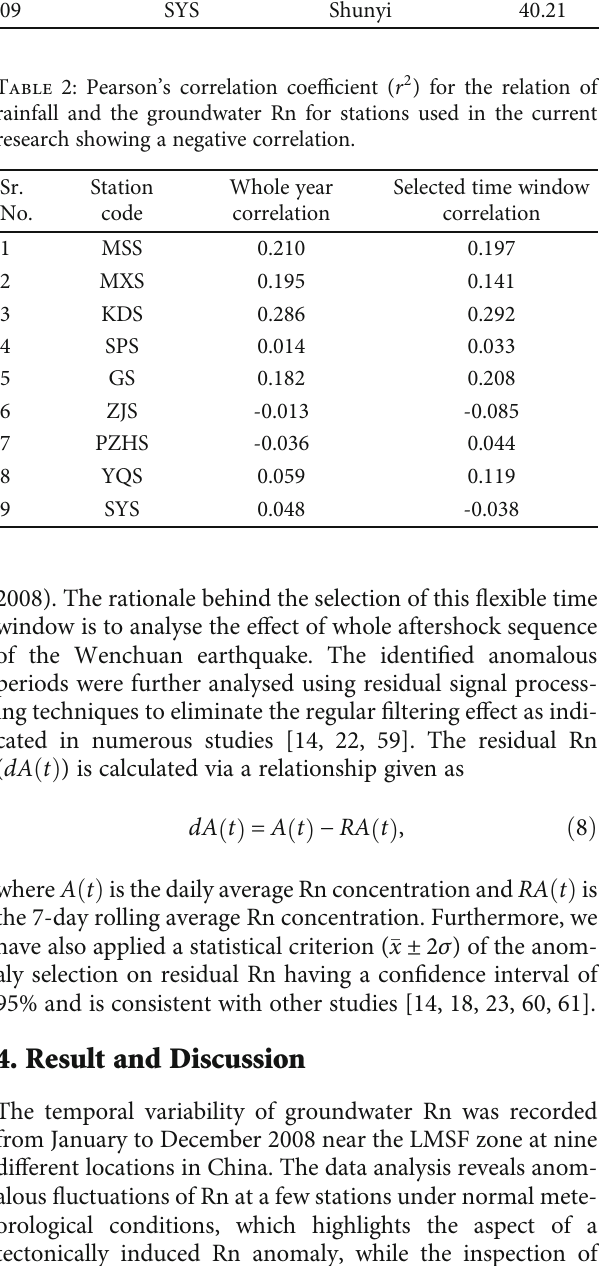
Table 2: Pearson ’ s correlation coe ffi cient ( r 2 ) for the relation of rainfall and the groundwater Rn for stations used in the current research showing a negative correlation.